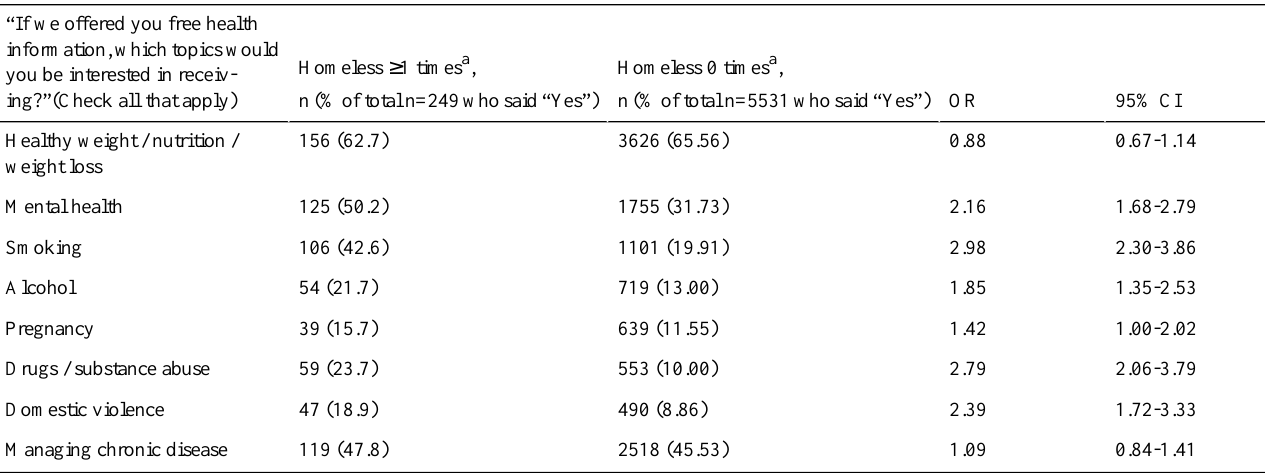
Table 3. Desire for health information by ED patients experiencing homelessness (% of adults in each group with desire for various health